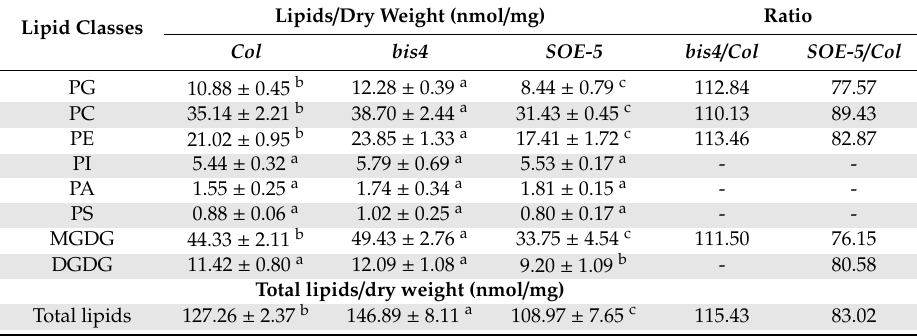
Table 1. Total lipids in Col , bis4, and SOE-5 plants.